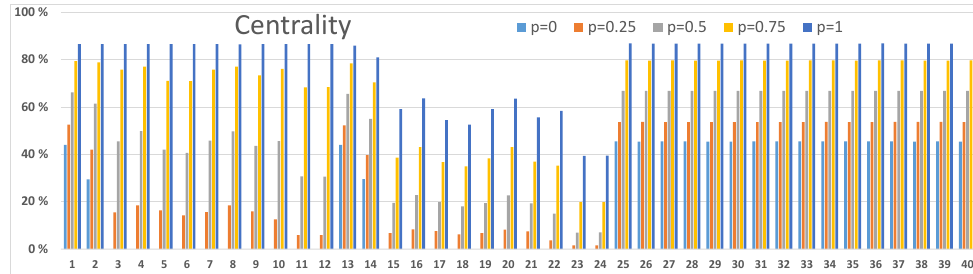
Figure 7. Centrality values of nodes in the network structure of Figure 1. Connections within networks are functioning with resilience values p = 0,0.25,0.5,0.75 and 1. The results correspond to Figure 4B.